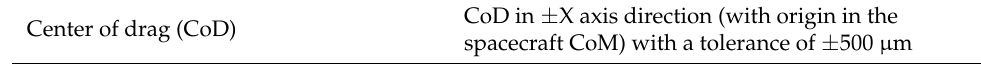
Table 1. Installation accuracy requirements of CoM-related parameters of GRACE-FO satellites. Center of drag